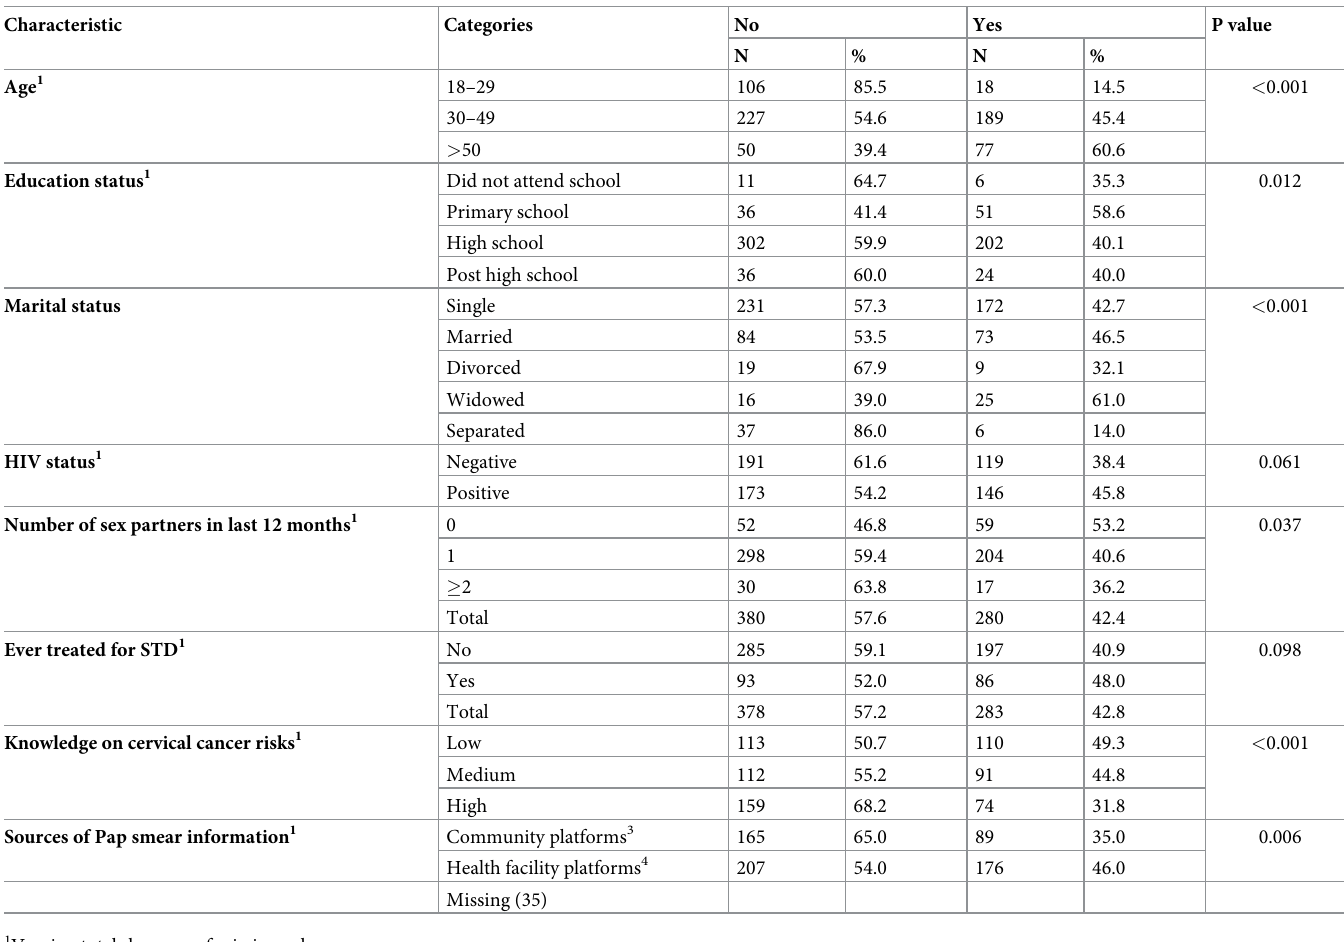
Table 2. Cervical cancer screening uptake according to various factors of the participants among black women in the past 10 years attending Pap smears in primary health care clinics in Gauteng Province, South Africa (N = 672). Characteristic